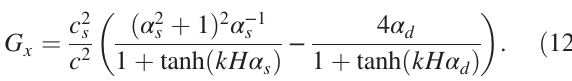
f 0 ð v Þ ) is varied . The parameters used are f ¼ 0 . 9 and β ¼ 0 . 3 , where γ ≡ μ = ( σ 0 c R s =c (i.e., for χ ≡ γ f < χ , sliding is stable for all k ) vs β ≡ c . The open symbols c c s d